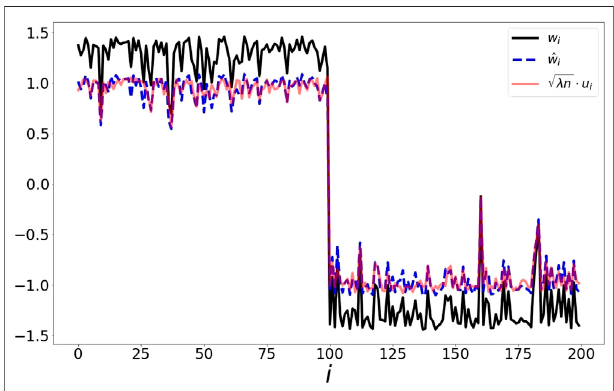
FIGURE 1 | Illustration of point set drawn from two distinct Gaussian distributions. The result of maximizing over the word2vec functional (black) is closelytracked(uptoscale) bytheoptimizer ofthespectral method (blue)and the eigenvector (red). In Figure 7 , we present a scatter plot comparing (cid:12)(cid:12)(cid:12) √ λ n the values of (cid:13) w and u